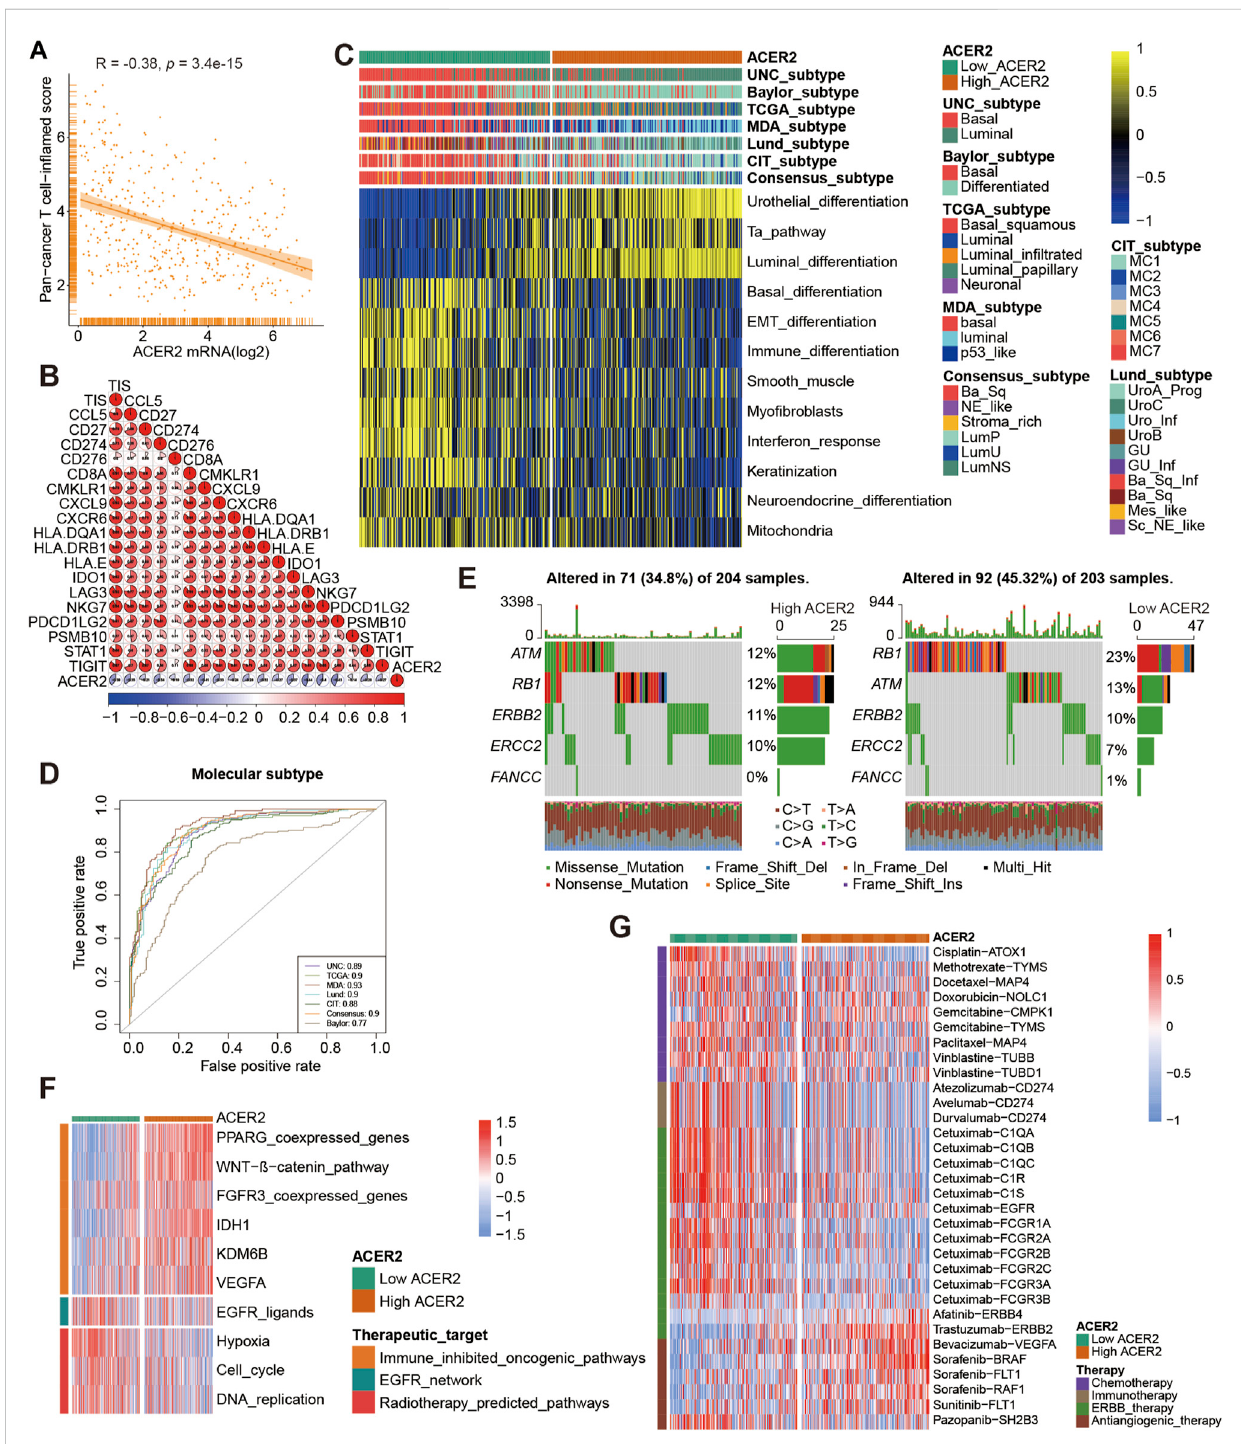
FIGURE 4 ACER2predictsthemolecularsubtypeandresponsetoseveraltherapiesinBLCA. (A,B) CorrelationbetweenACER2withTISandthecorresponding TIS-related effector genes. (C) Correlations between ACER2 and molecular subtypes with seven different subtyping systems. (D) ROC analysis on the prediction accuracy of ACER2 for molecularsubtypes with different systems. (E) Mutational pro fi les ofneoadjuvant chemotherapy-related genesin low- and high-ACER2 tissues. (F) Correlation between ACER2 and the enrichment scores of therapeutic signatures. (G) Correlation between ACER2 and the drug-target genes of various